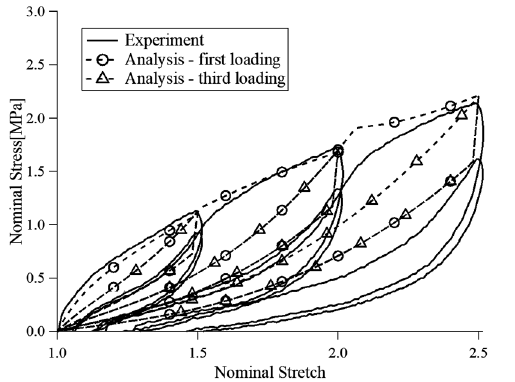
Figure 2. Cyclic tensile loading test results (Strain rate =